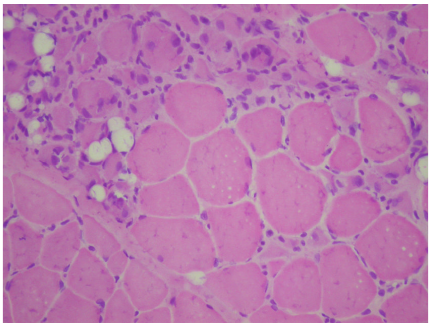
Figure 2: Immature pathological fibers visualized with anti- neonatal myosin antibody staining (DABx